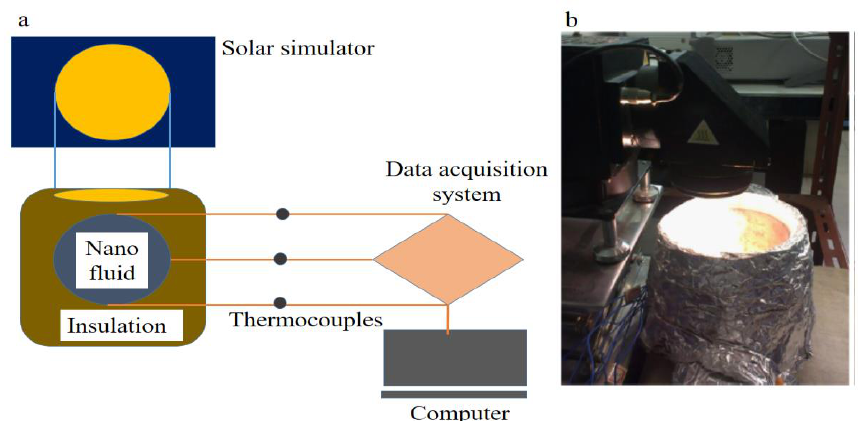
Fig. 9. (a) Schematic diagram of direct absorption solar thermal collector system; (b) Experimental setup with solar simulator and a receiver with graphene/[HMIM]BF 4